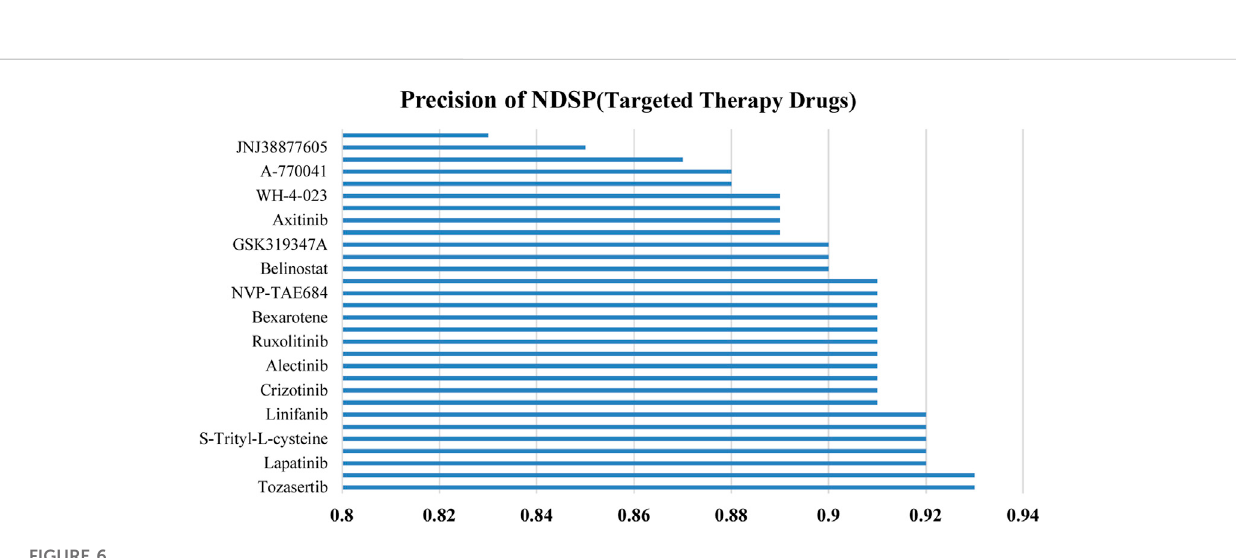
FIGURE 6 Precision of NDSP on targeted therapy